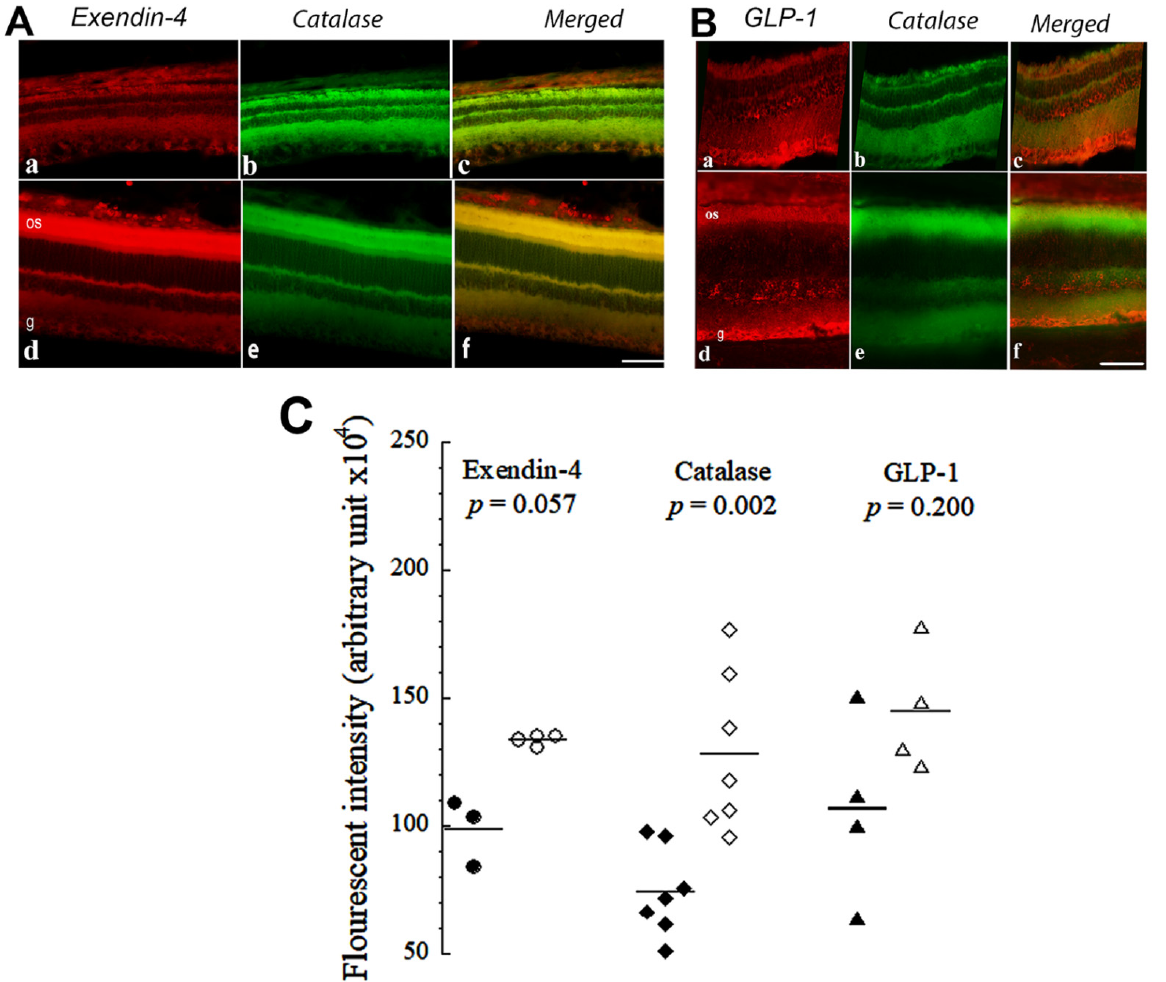
Figure 2. ( A ) Immunofluorescence images of Extendin (EXE-4) ( a , d ), catalase (CAT) ( b , e ) and merged signals ( c , f ) in the retina of non-diabetic ( a – c ) and diabetic ( d – f ) rats. ( B ) Immunofluorescence images of GLP-1 ( a , d ), CAT ( b , e ) and merged signals ( c , f ) in the retina of non-diabetic ( a – c ) and diabetic ( d – f ) rats. Scale bar = 25 µm. Note that EXE-4 and GLP-1 colocalize with CAT (merged signals ( c , f )). ( C ) Dot plot of the total fluorescent intensities of experiments ( A , B ), respectively, using Image J software (NIH, Bethesda, MA, USA). Filled symbols are non-diabetic retinas and unfilled symbols are diabetic retinas (number of independent measurements = 4–7). The value of p is based on non-parametric, 2 independent samples (Mann–Whitney) test. The horizontal lines represent the mean. os = outer segment of photoreceptor cells; g = ganglion cell layer of